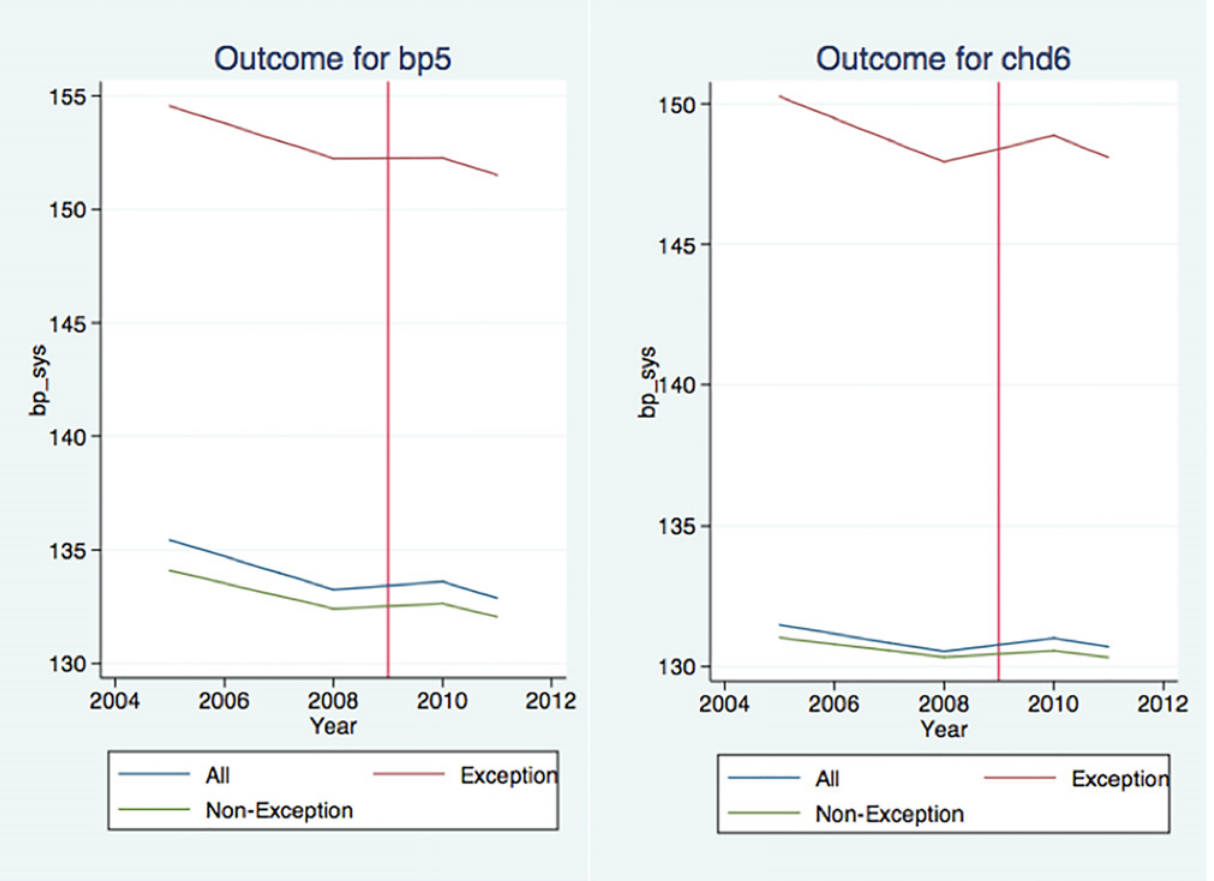
Fig 2. Systolic blood pressure as clinical outcome for hypertension patients (left) and coronary heart disease patients (right). The panels compare the blood pressure between all patients, exception reported patients and non-exception reported